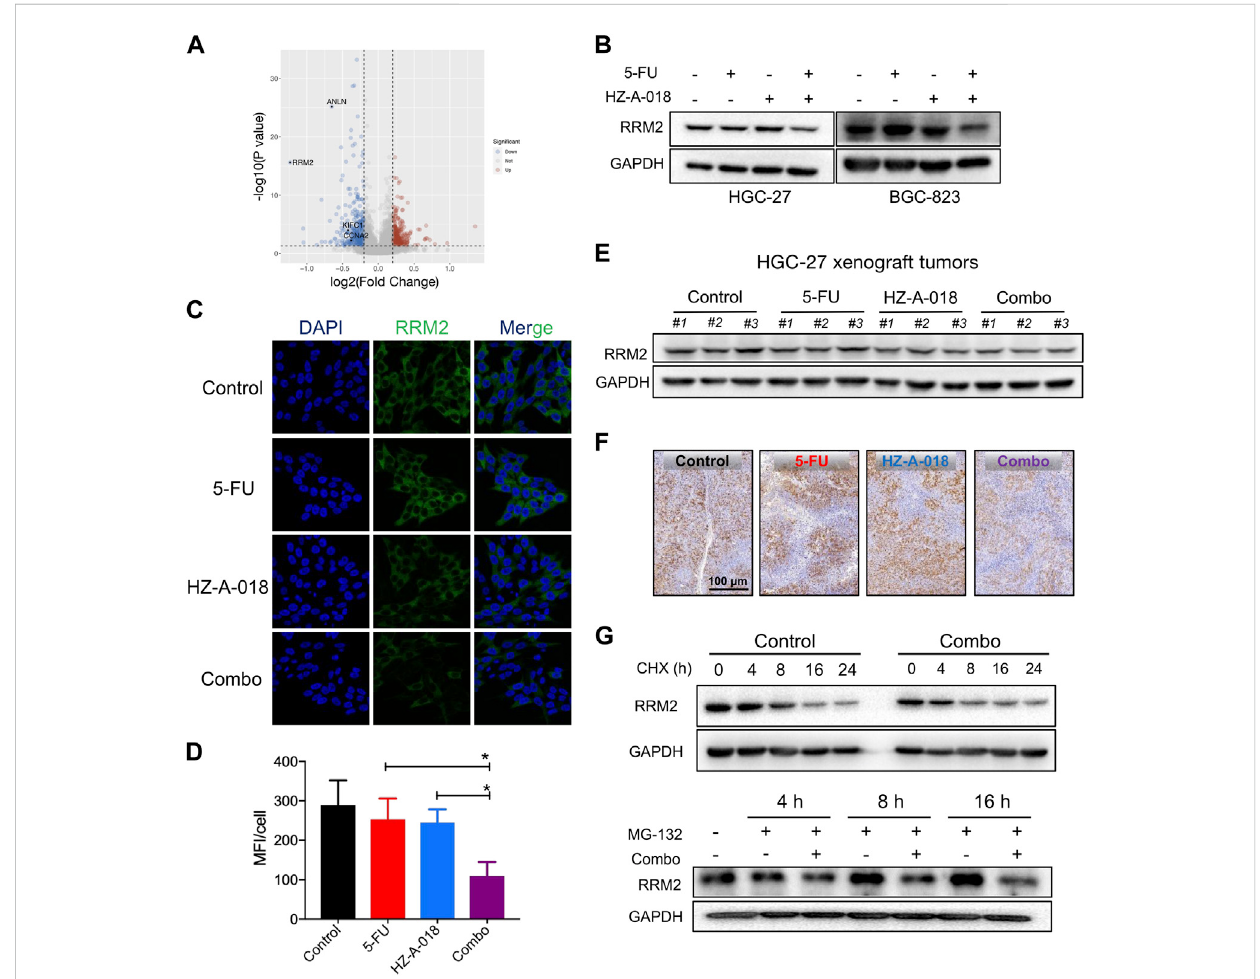
FIGURE 4 Thecombined treatmentof5-FUandHZ-A-018diminished theexpressionofRRM2. (A) A Volcanoplotshowedtheproteomics analysis comparing the combination of 5-FU and HZ-A-018 with 5-FU alone for 24 h in HGC-27 cells ( n = 3 independent experiments). (B) Western blotting of RRM2 after combinatorialtreatmentwith5-FUandHZ-A-018for48 h. (C) Immuno fl uorescentimagesshowedthedecreaseofRRM2expressionaftercombinatorial treatment for 48 h. (D) Quantitative analysis of ( C ). (E) Western blotting of RRM2 in dissected tumor tissues. (F) In situ analysis of RRM2 expression in tumor tissues by Immunohistochemistry. (G) The time-dependent change of RRM2 expression pretreated with 40 µM of CHX or 5 µM of MG-132. * p <